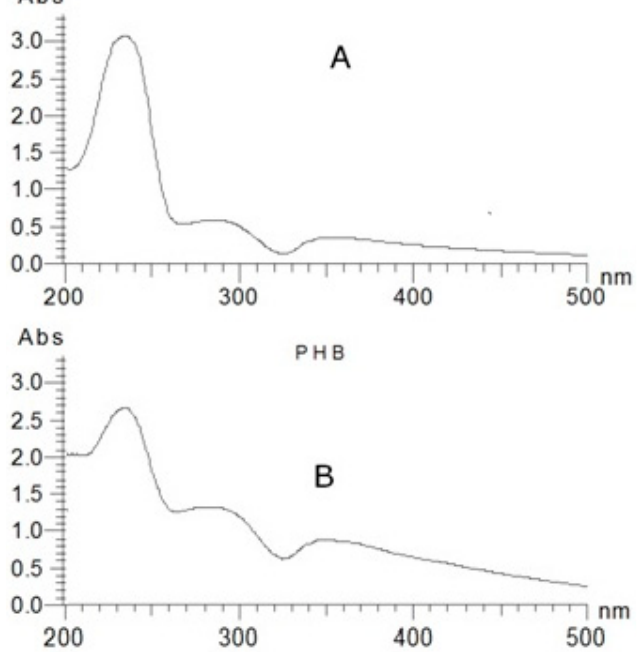
Figure 1. Crotonic acid peak (at 235 nm) of standard poly- β -hydroxybutyric acid ( A ) and polyhydroxybutyrate (PHB) isolated from Scytonema geitleri ( B ).